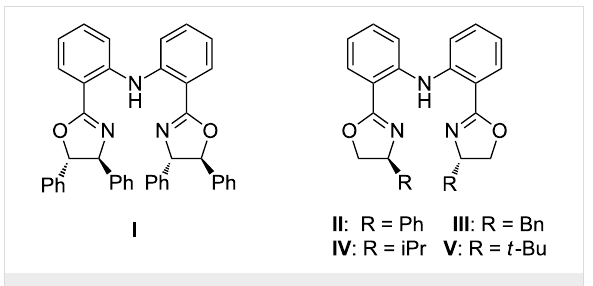
Figure 1: Diphenylamine-linked